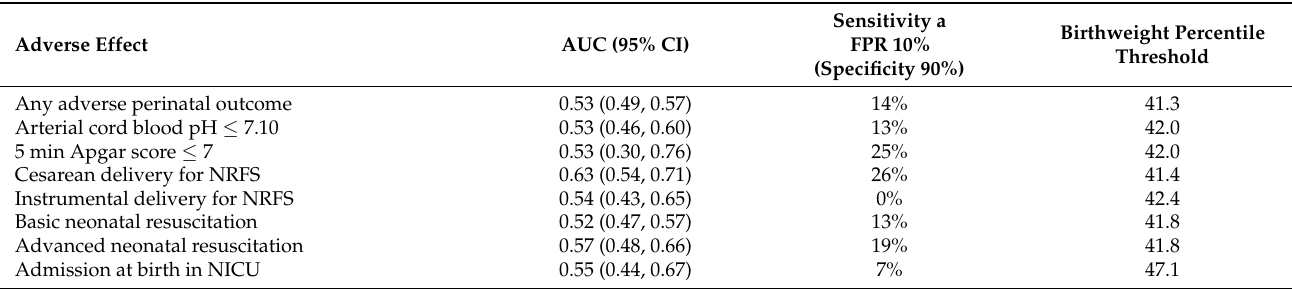
Table 3. Values of area under the receiver operating characteristic curves (AUCs) and sensitivities plus the